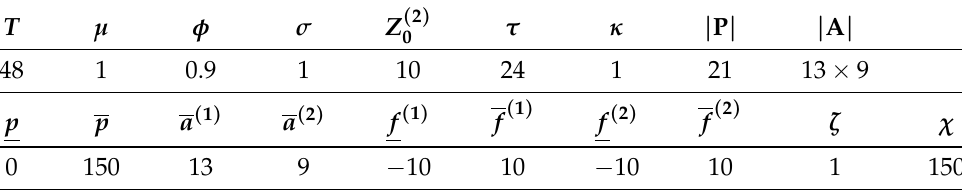
Figure 3. The upper and lower plots depict sample paths for the state process ( Z corresponding long-term electricity prices ( ψ t ) T Table 1. The values of the parameters used in the numerical